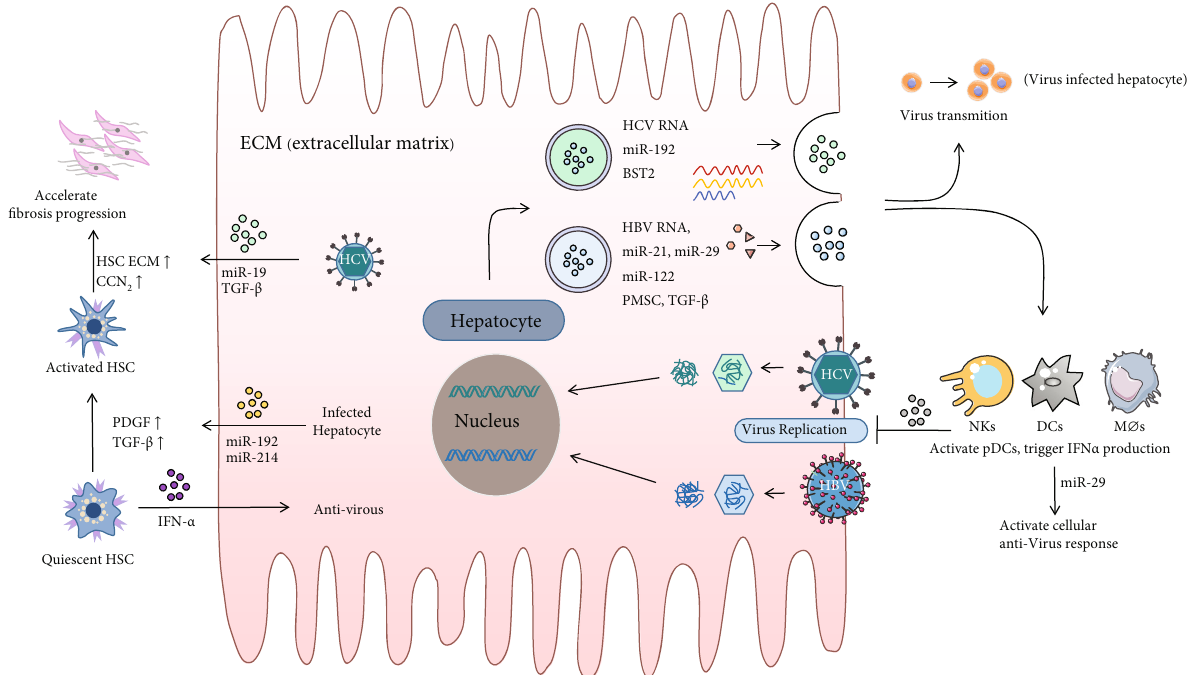
Figure 4: The schematic represents exosomes in viral hepatitis and their molecular mechanisms by which exosomes regulate cellular communication in liver. As indicated in the fi gure, the hepatitis B virus (HBV) and hepatitis C virus (HCV) rely on exosomes to spread viral RNAs and protein to adjacent liver cells, and these particles facilitate the spread of the virus as well as destroy the innate immune response of the